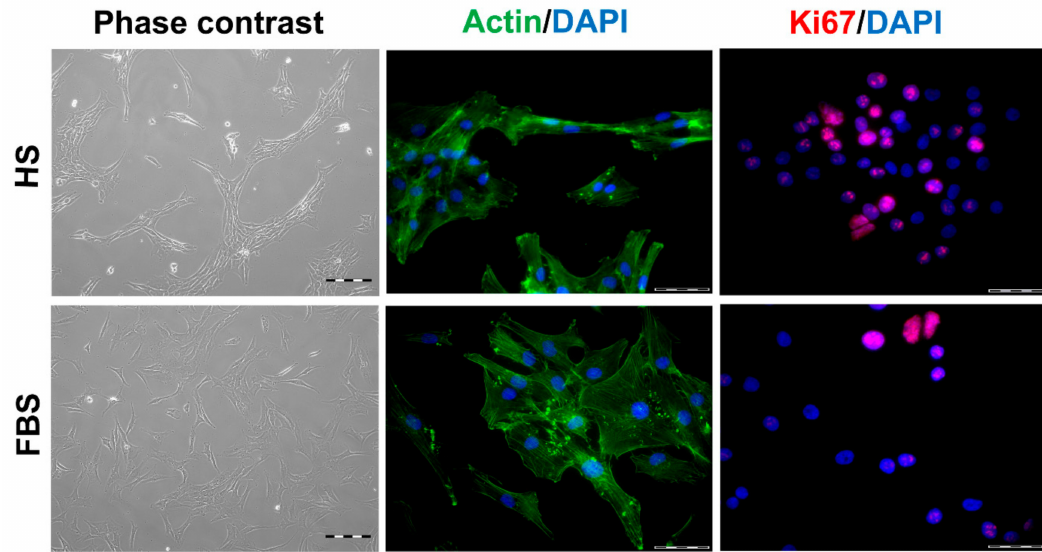
Figure 2. Morphology and proliferative activity of isolated chondrocytes of a representative donor. Passage 2 (P2) chondrocytes were cultivated with the medium containing either human serum (HS) or fetal bovine serum (FBS), and the morphology was documented via phase contrast microscopy (left). The cells were further analyzed via staining of actin structures using Alexa Fluor 488-conjugated phalloidin (green, middle). The proliferative activity was visualized via indirect immunocytochemical staining of Ki67 (red, right). Cell nuclei were stained with DAPI (blue). Scale bars: 200 µ m (left) and 50 µ m (middle and